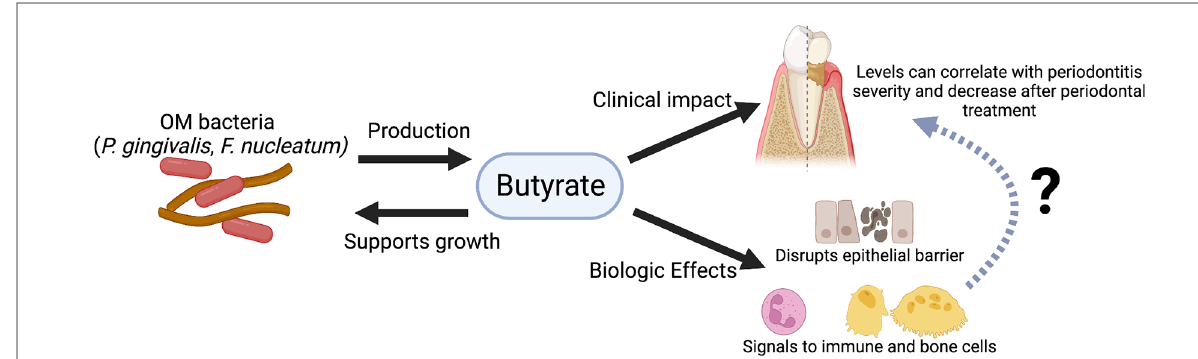
FIGURE 2 Graphical summary of evidence for butyrate ’ s role in periodontitis. Periodontitis-associated bacteria found within the OM (e.g., P. gingivalis and F. nucleatum ) produce butyrate, which in turn can support their growth. Clinical studies have shown an association between butyrate levels and periodontitis and found that butyrate levels decrease after periodontal treatment. Experimental studies indicate butyrate may disrupt the junctional epithelial barrier and can signal to immune and bone cells. However, the exact mechanisms connecting butyrate and its possible biologic effects to periodontitis and alveolar bone are still unknown. Figure created with